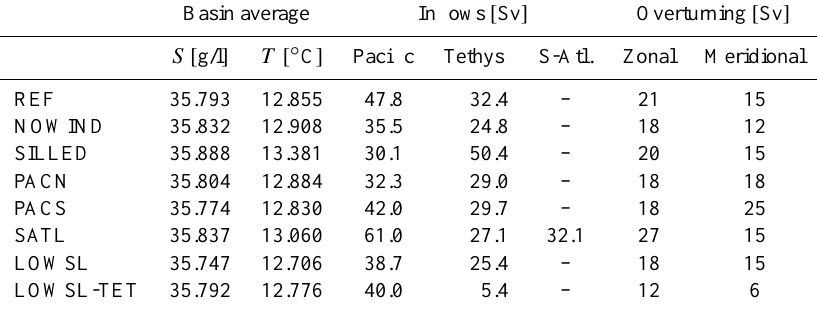
Table 3. Results. Summary of results.